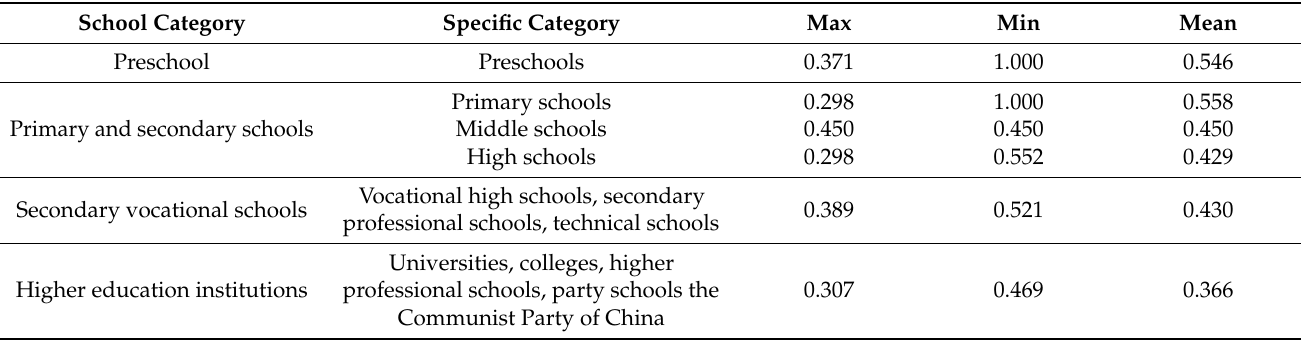
Table 3. Characteristic values of urban land accessibility of locations of various levels of educational facilities in Zhicheng Town, Changxing